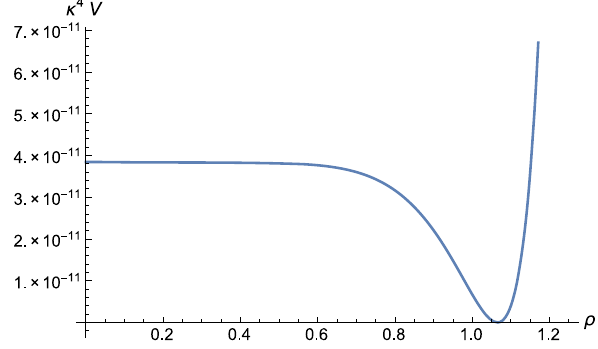
Fig. 5 This plot shows the scalar potential for F = 0, b = 3 / 2, A =